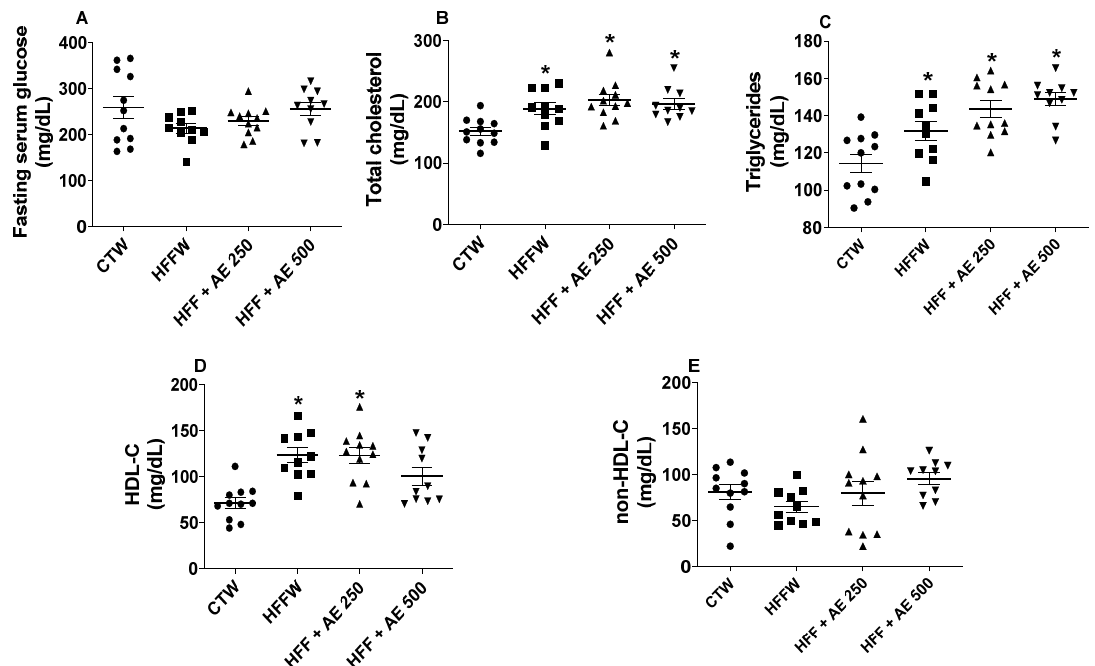
Figure 6. The effects of the high-fat/high-fructose diet and M. citrifolia (noni) aqueous extract (AE) on the serum biochemical parameters. ( A ) The fasting blood glucose (mg / dL); ( B ) total cholesterol (mg / dL); ( C ) triglycerides (mg / dL); ( D ) high-density lipoprotein cholesterol (HDL-C) (mg / dL); ( E ) non-HDL-C (mg / dL) of full black circle: CTW (CT + drinking water, n = 11), full black quadrilateral: HFFW (high-fat / high-fructose diet + drinking water, n = 10); black up-pointing triangle: HFF + AE 250 (HFF + M. citrifolia fruit aqueous extract of 250 mg / kg of body weight, n = 11); and black down-pointing triangle: HFF + AE 500 (HFF + M. citrifolia fruit aqueous extract of 500 mg / kg groups, n = 10) for seven weeks (10th to 16th weeks). The results are expressed as the mean ± SEM. * = p ≤ 0.05 vs. CTW. ANOVA, followed by the Tukey post-test.